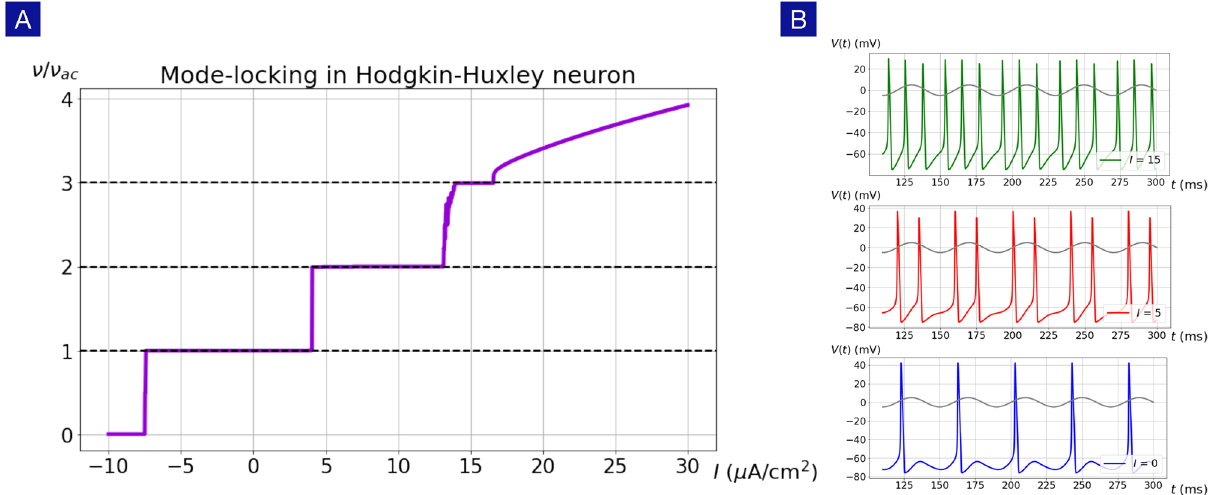
Figure 2. Mode-locking in the Hodgkin-Huxley neuron. ( A ) The firing rate of the Hodgkin-Huxley neuron exhibits roust plateaus at ν = n ν ac , where n is an integer, in the presence of an external ac drive with frequency ν ac = 25 Hz. ( B ) Action potentials at I = 0, 5, 15 µ A/cm 2 exhibit different mode-locking behaviors with ν/ν ac = 1, 2, 3